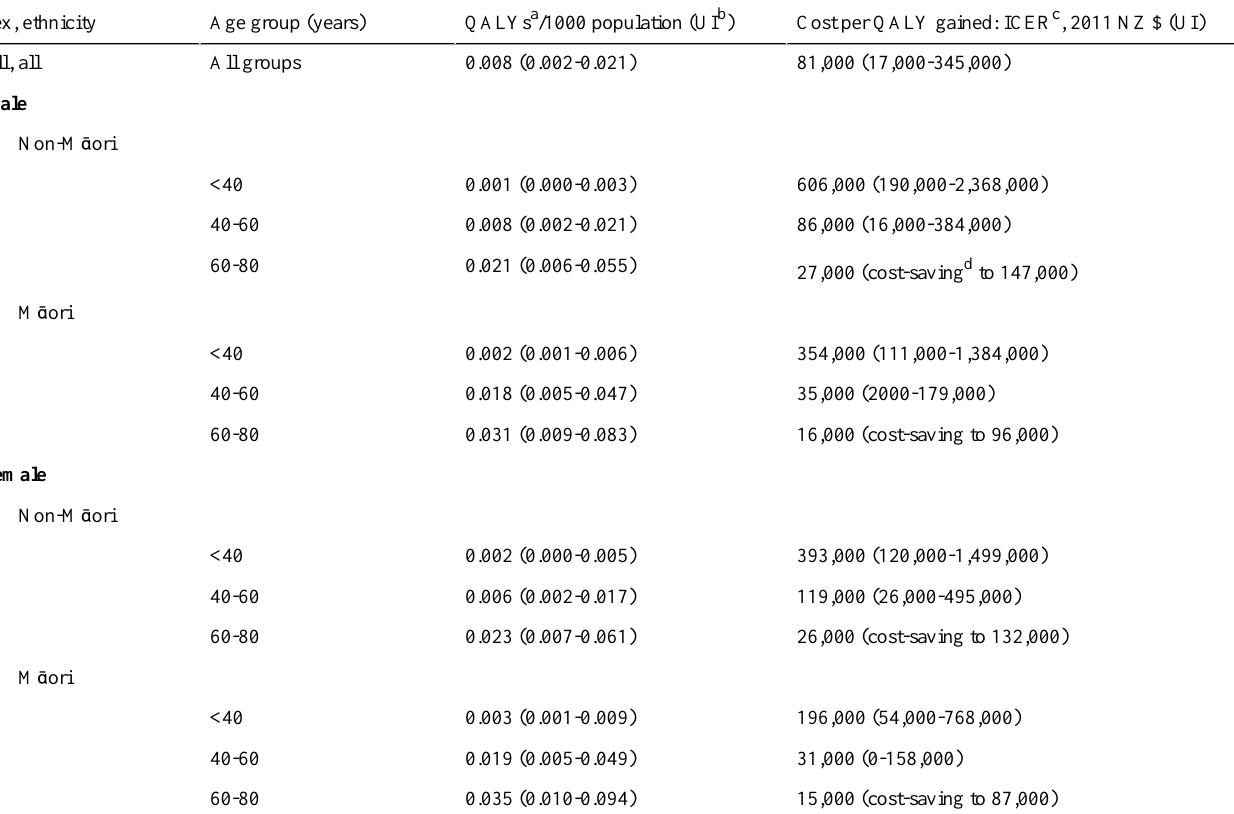
Table 2. Health gains and cost-effectiveness of a mass media campaign to promote physical activity smartphone apps by age, sex, and ethnicity (lifetime gains, 3% discount rate).